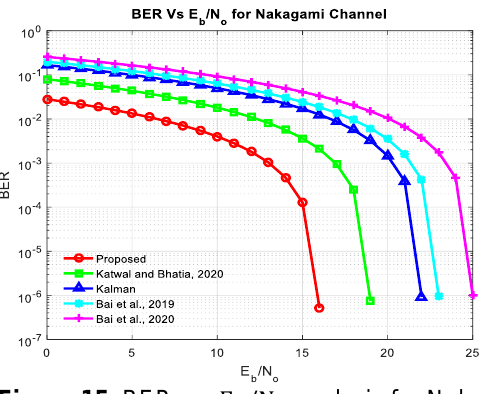
Figure 15. BER vs. E